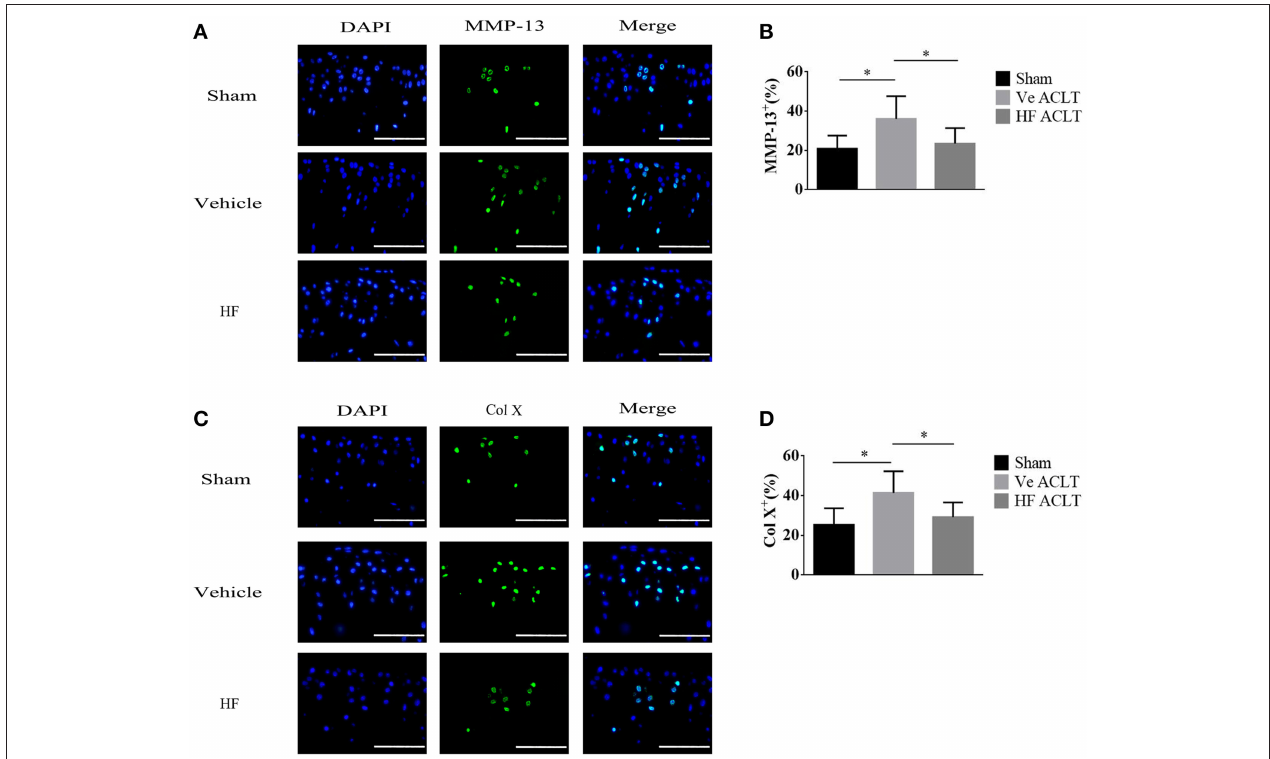
FIGURE 2 | HF reduced the number of MMP-13 positive and Col X positive cells in articular cartilage at 30 d after ACLT. Immunofluorescent staining and quantitatively analysis of MMP-13 (A,B) and Col X (C,D) . Scale bar, 100 µ m. * p < 0.05 as denoted by bar.